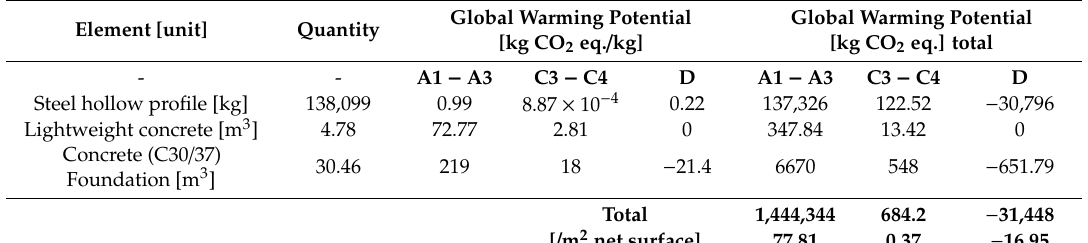
Table 5. Shear walls system data collection and LCIA results (Source: Generis